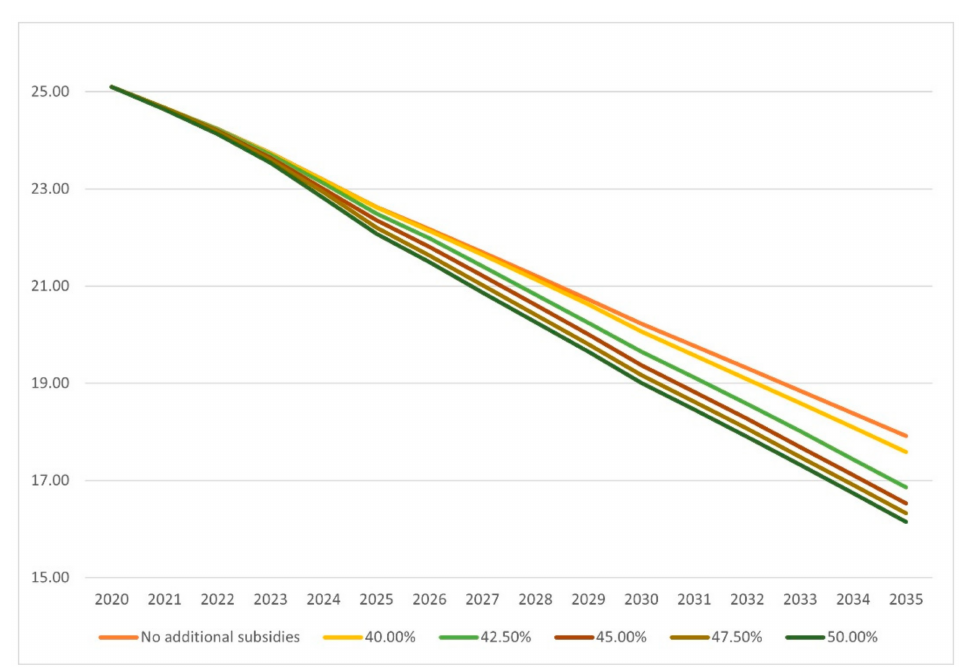
Figure 5. GHG emissions under different state subsidy schemes for Lower Saxony.